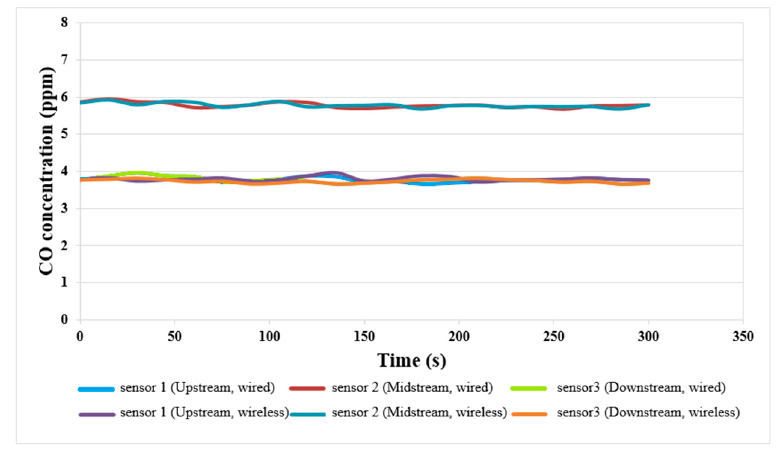
Figure 12. Local CO concentration distribution diagram of wired and wireless sensors.